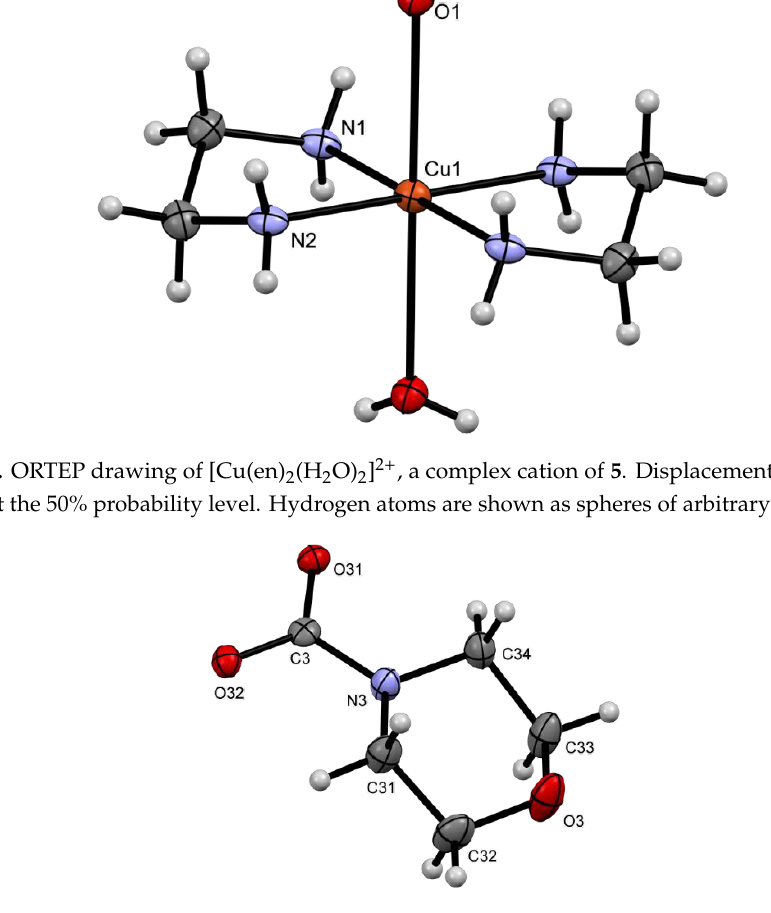
Figure 9. ORTEP drawing of morphCOO − , a counter-anion of 5 . Displacement ellipsoids are drawn at the 50% probability level. Hydrogen atoms are shown as spheres of arbitrary radii.